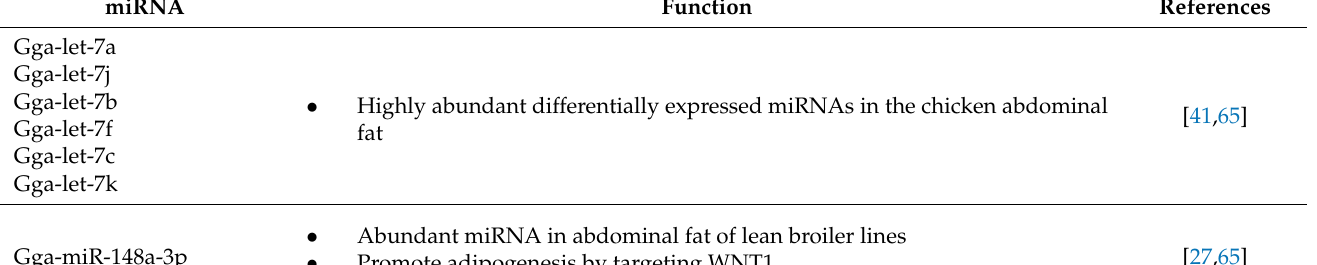
Table 2. Summary of the significantly expressed miRNAs in chicken abdominal fat. miRNA